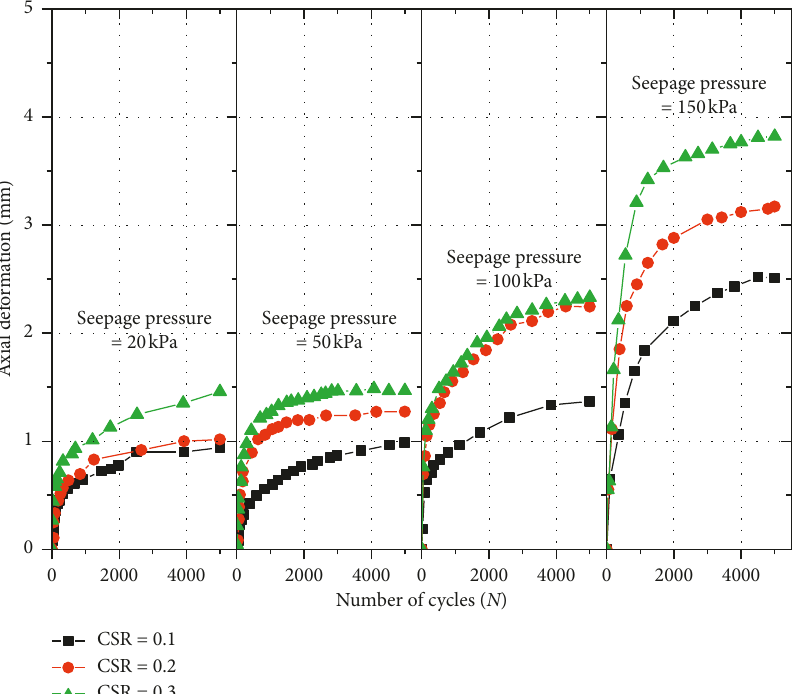
Figure 9: Relationships between axial deformation and N under different CSR values and seepage pressures.